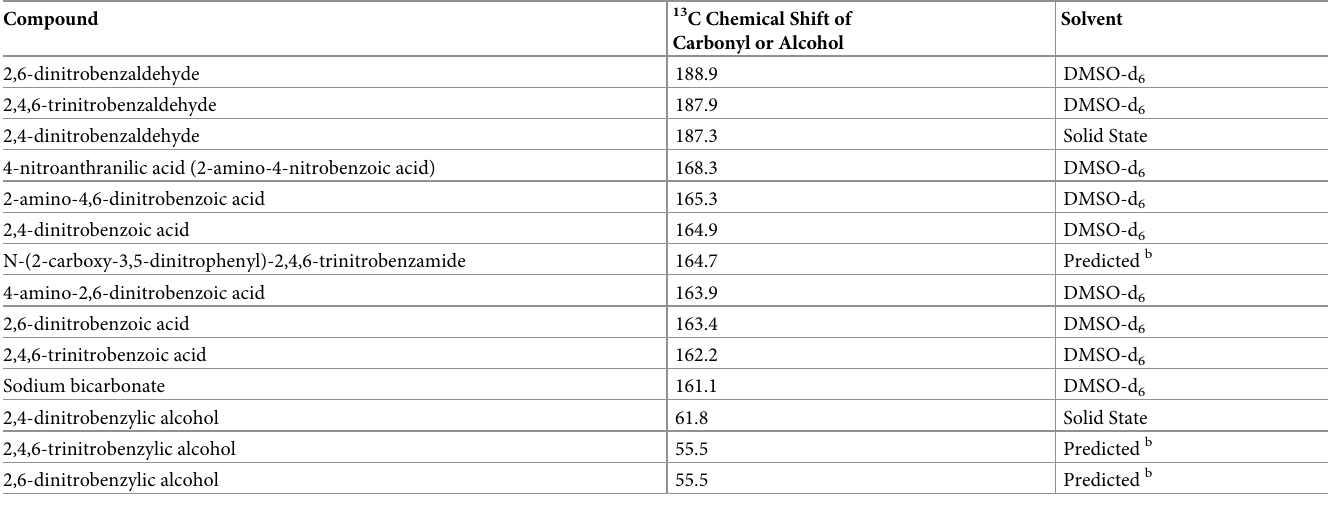
Table 2. C-13 NMR chemical shifts of carbonyl and alcohol carbons a